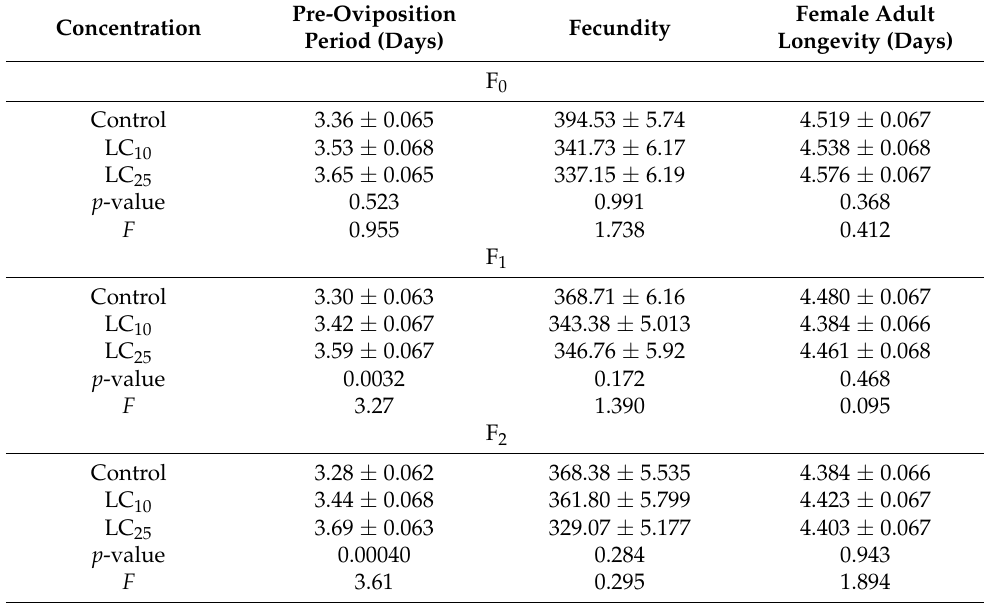
Table 3. Sub-lethal (LC 10 , LC 25 ) effects of chlorantraniliprole on reproductive parameters of Spodoptera frugiperda for 3